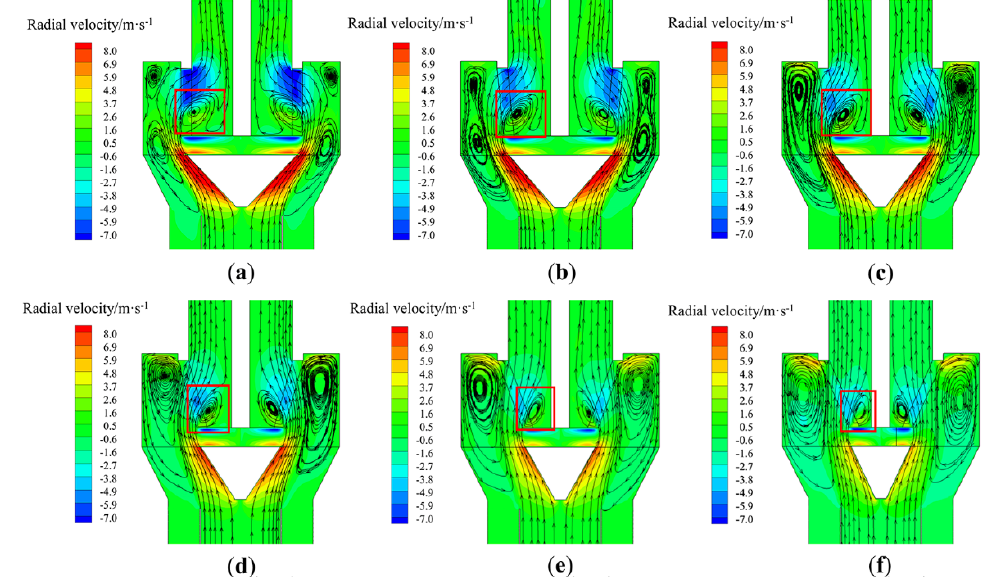
Figure 5. Comparison of radial velocity contours and gas pathlines in the classifying chamber: ( a ) T-A (1-1) , ( b ) T-B (1-0.9) , ( c ) T-C (1-0.8) , ( d ) T-D (1-0.7) , ( e ) T-E (1-0.6) , and ( f ) T-F (1-0.5)